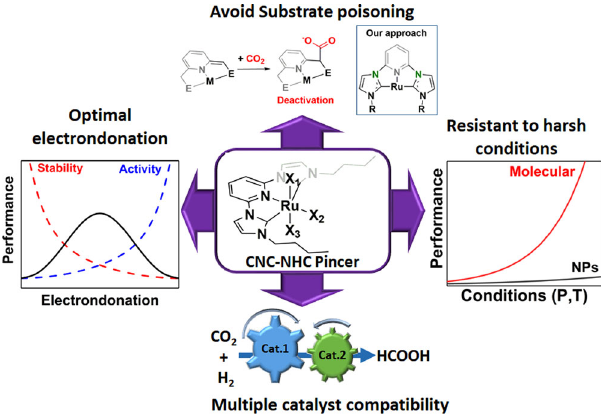
Fig. 1 Catalyst design strategy. The molecular catalyst (centre) should be resistant to deactivation by the substrates (top), tune the electrondonation of the ligand to the metal centre to balance stability and activity (left), resist the increasingly acidic media and strong reductive conditions (right) and be compatible with other catalysts